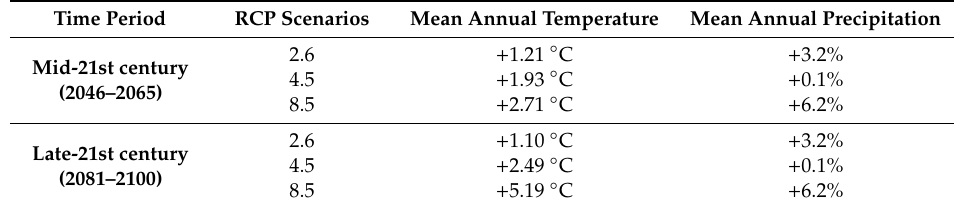
Table 2. Representative Concentration Pathways (RCPs) scenarios downscaled for the Indus River Basin and used in the current study to project future river flows.